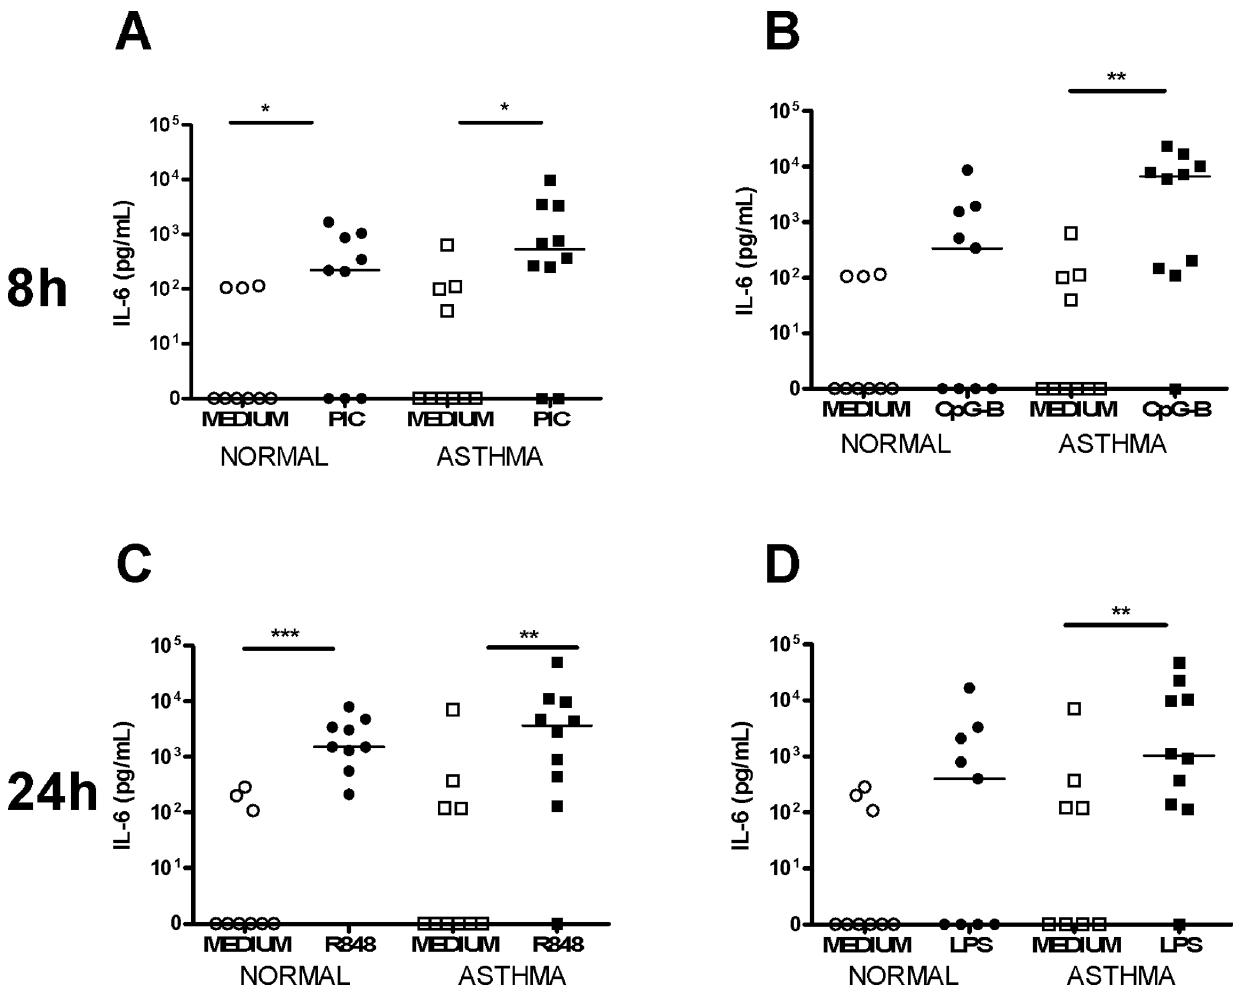
Figure 3. IL-6 induction following TLR stimulation in HBECs. Graphs depict IL-6 production at 8 h following stimulation with PIC [A] and CpG- B-ODN [B] and at 24 h following R848 [C] and LPS [D]. Squares represent asthmatics, circles represent non-asthmatics. *=p , 0.05, **=p , 0.01, ***=p , 0.001.